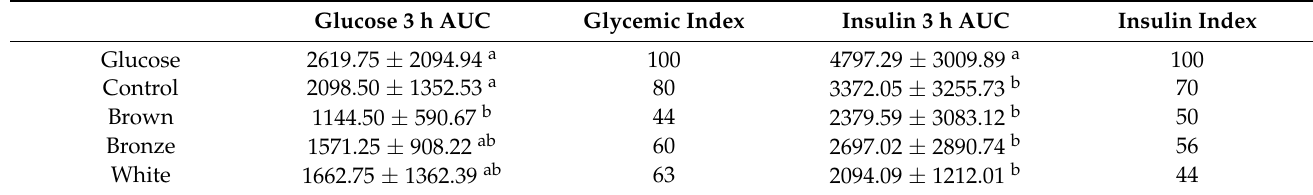
Table 2. Glycemic and insulinemic index (%) of control and sorghum bread. Glucose 3 h